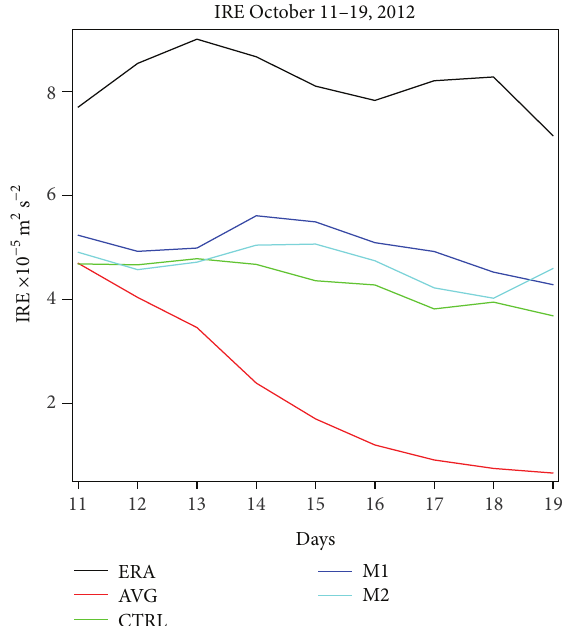
Figure 5: ERA and GEFS values of IRE for October 11–19, 2012. Shown are ERA reanalysis (black), GEFS ensemble mean (red), GEFS control (green), and two other ensemble members (dark and light